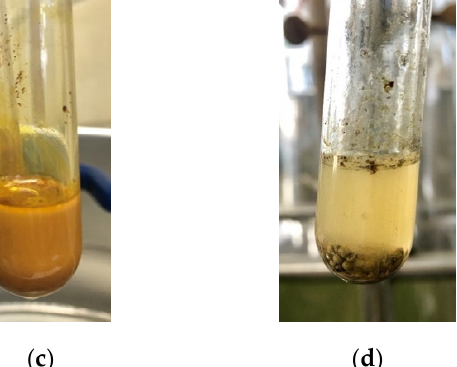
Figure 5. The appearance of the reaction mixture of Sonogashira coupling with NS . ( a ) The aqueous polymer solution. ( b ) Before the reaction with substrates. ( c ) During the reaction. ( d ) Cooled after the reaction with precipitated chunks.